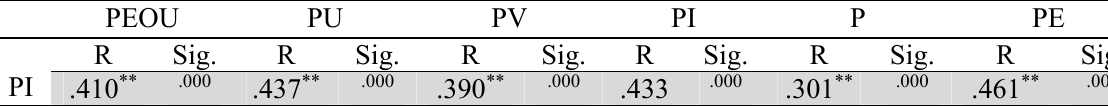
Showing Pearson correlation among variables PEOU PU